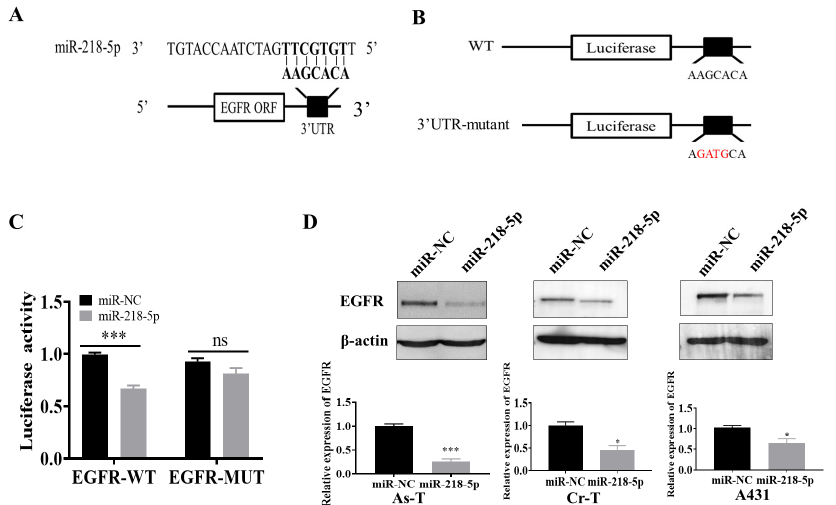
Figure 3. EGFR as a direct target of miR-218-5p. ( A ) The 3 (cid:48) -UTR region of EGFR to which miR-218-5p binds. ( B ) Luciferase reporter constructs containing wild-type (WT) and EGFR 3 (cid:48) -UTR mutant (MUT) plasmid. ( C ) Relative luciferase activities measured with miR-NC or miR-218-5p overexpression using HEK-293 T cells. Renilla luciferase reporter was used as an internal control. Data were represented by means ± SE. ( D ) As-T, Cr-T, and A431 cells transfected with miR-NC or miR-218-5p mimic, and the EGFR and β -actin protein expression measured using immunoblotting assay. * p < 0.05; *** p < 0.001; ns, not significant. The original western blots of this figure is Figure